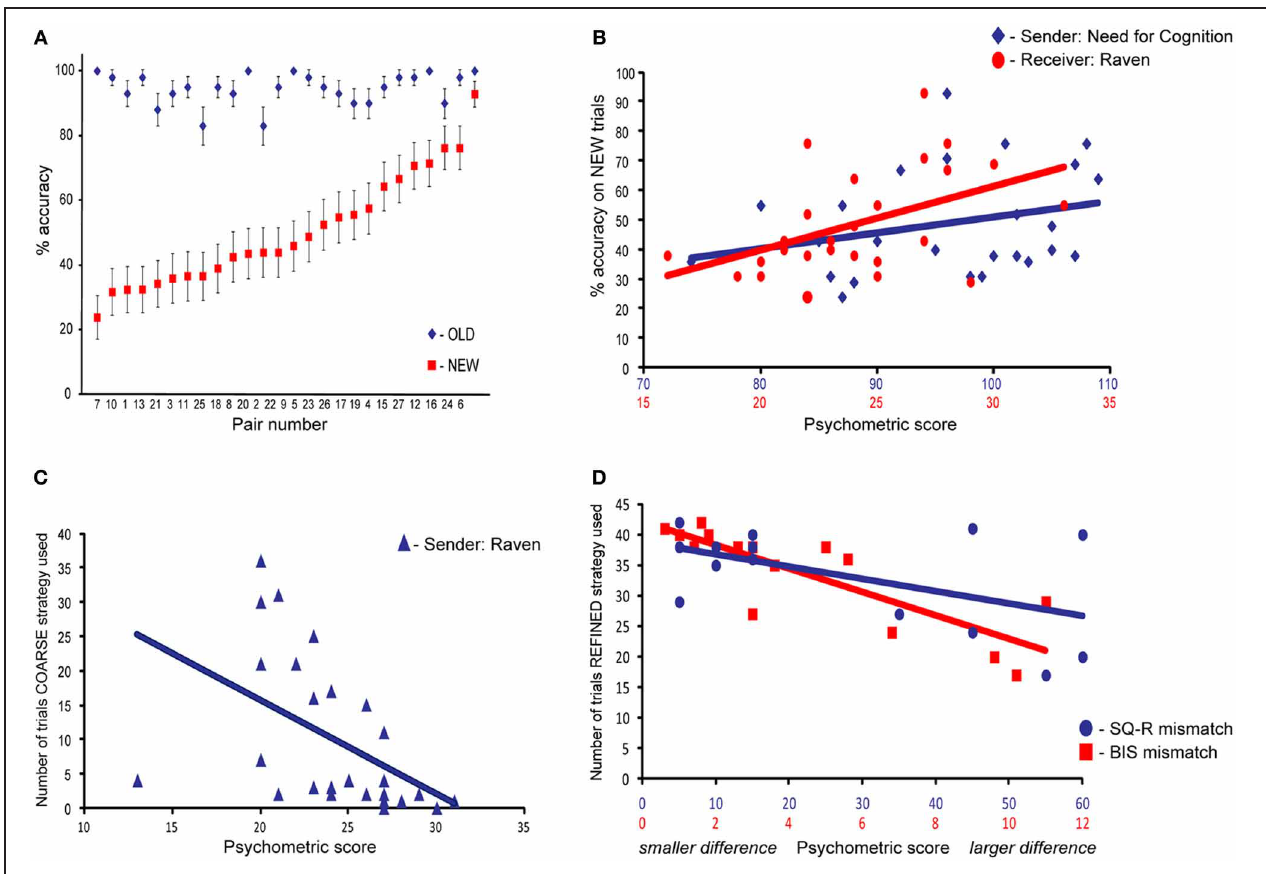
FIGURE 6 | (A) Mean accuracy scores for OLD and NEW problems for each pair of participants. (B) Scatterplot of the relation between performance during NEW trials, senders’ Need for Cognition score, and receivers’ Raven score. (C) Scatterplot of the relation between frequency